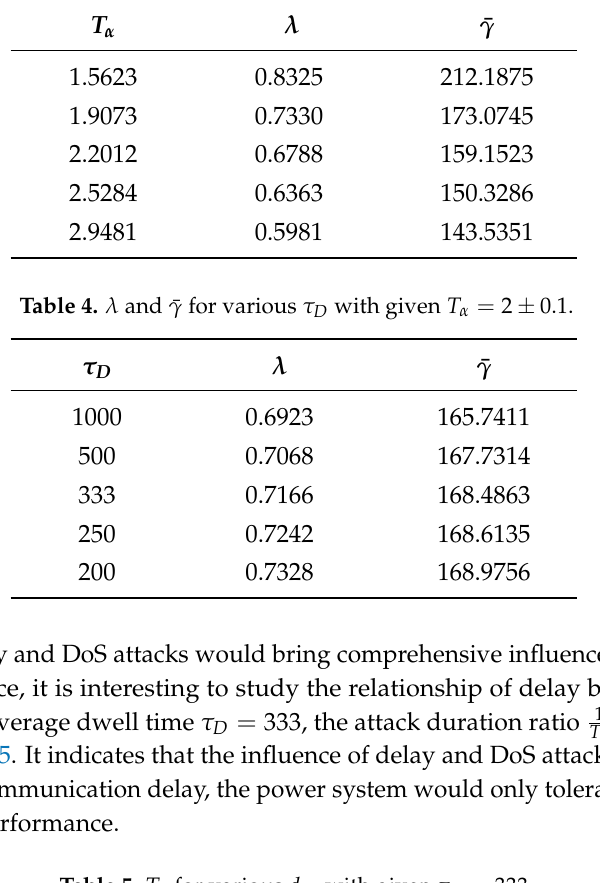
Table 5. T α for various d M with given τ D =